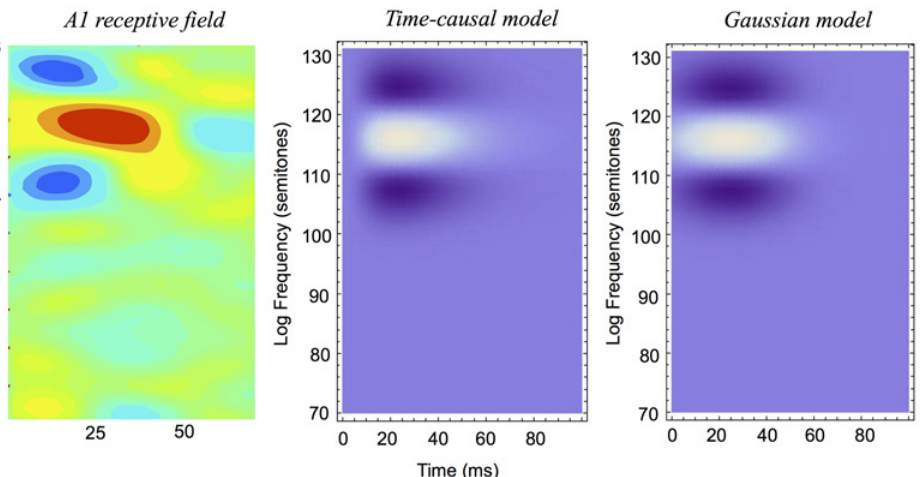
Fig 19. (left) A separable spectro-temporal receptive fields in the primary auditory cortex (A1) of ferret as reported by Elhilali et al. [39] (schematic simplification only, see fig. 6(a) in [39] or fig. 20 in [64] for the original data). (middle and right) Idealized receptive fields models (90) corresponding to second- order derivatives with respect to logarithmic frequency centered at semitone ν = 116, temporal scale σ t = 17 ms, logspectral scale σ ν = 5 semitones for both models and additionally temporal delay δ = 25 ms for the Gaussian model.